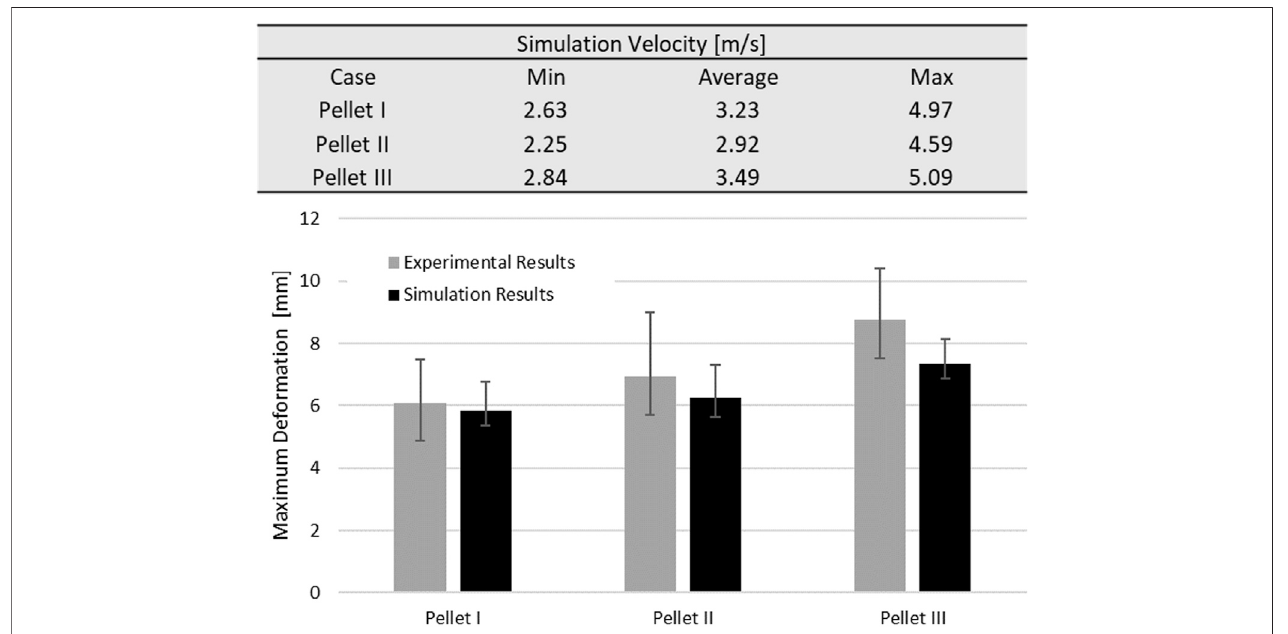
FIGURE11| Spinalcordimpactmodelvelocitysensitivitystudy.Valuesofminimum,maximumandaveragevelocitieswerecalculatedfrombasedoninitialslopeof the experimental data (pellet trajectories).